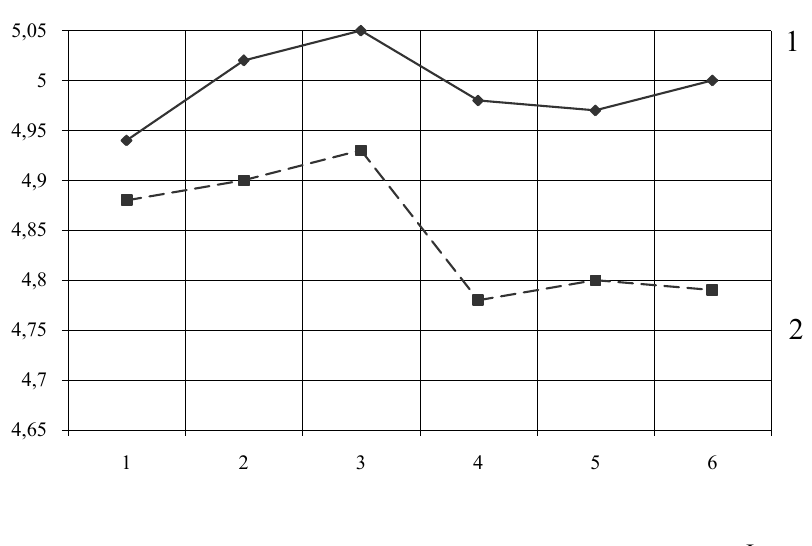
Fig.1. Comparative analysis of 6 long jumps with middle distance (11-12 run steps) running